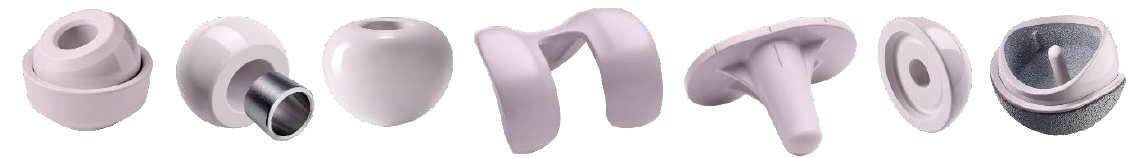
Figure 2. AMC BIOLOX ® delta products (Courtesy CeramTec GmbH, Plochingen,